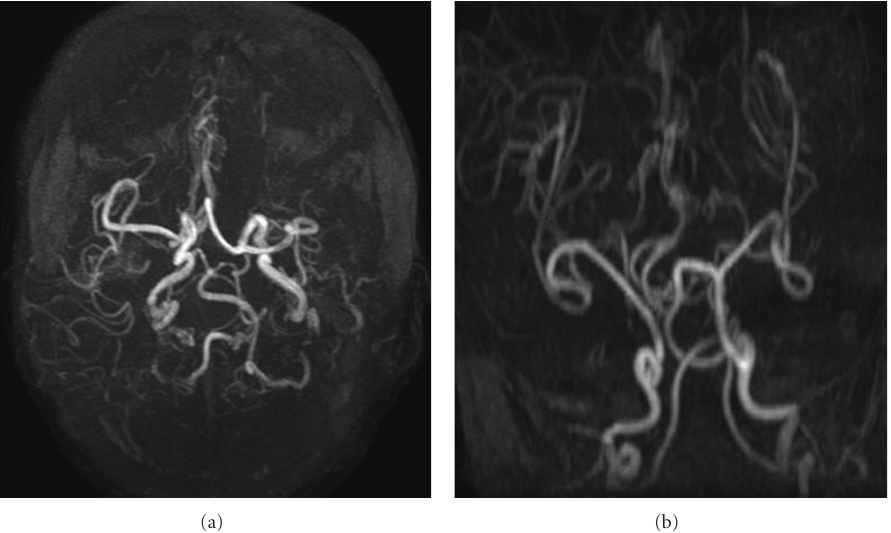
Figure 5: MR angiography: Axial and coronal maximum intensity projection image of brain on Siemens 3Tesla TIM Trio machine showing tortuous intracranial vessels (TR: 21.4, TE: